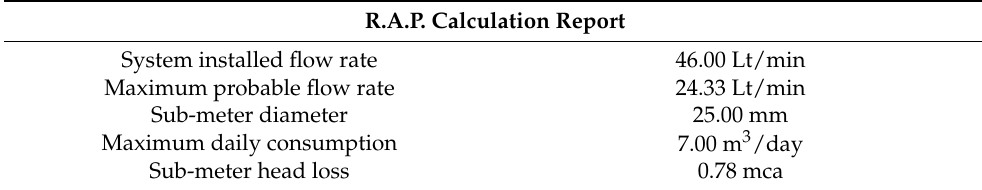
Table 19. Sub-meter calculation report for type 2 retail